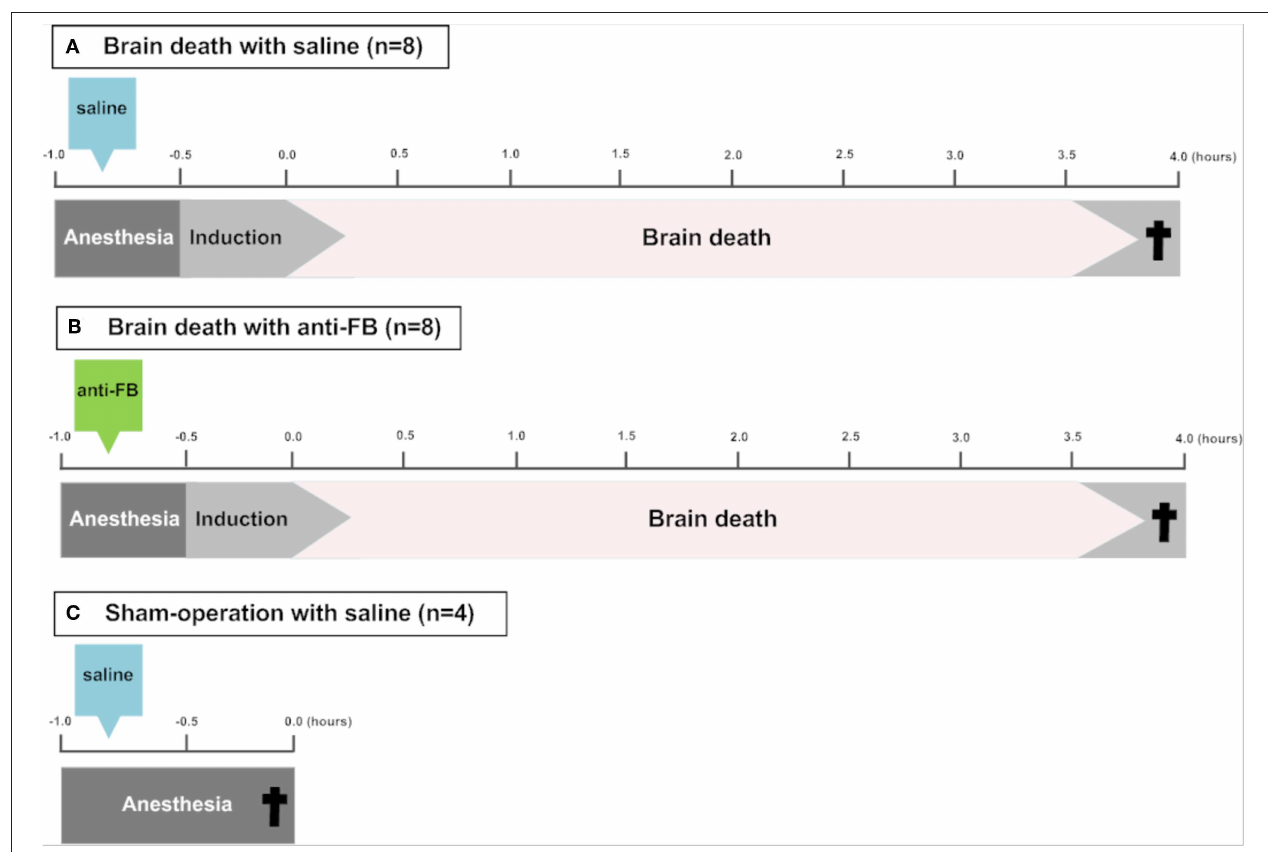
FIGURE 1 | Schematic overview of the experimental set-up. To induce brain death, a catheter was placed in the epidural space through a frontal-lateral borehole in the skull and inflated slowly over 30min. (A) Saline or (B) anti-factor B (anti-FB) was administered via the femoral vein 20min before the induction of brain death. After 4h of brain death, rats were sacrificed and blood, urine and kidneys were collected. In (C) sham-operated rats, a hole was drilled in the skull without insertion of the balloon catheter and rats were ventilated for 30min under anesthesia before sacrifice. † Termination. Anti-FB, anti-factor B.